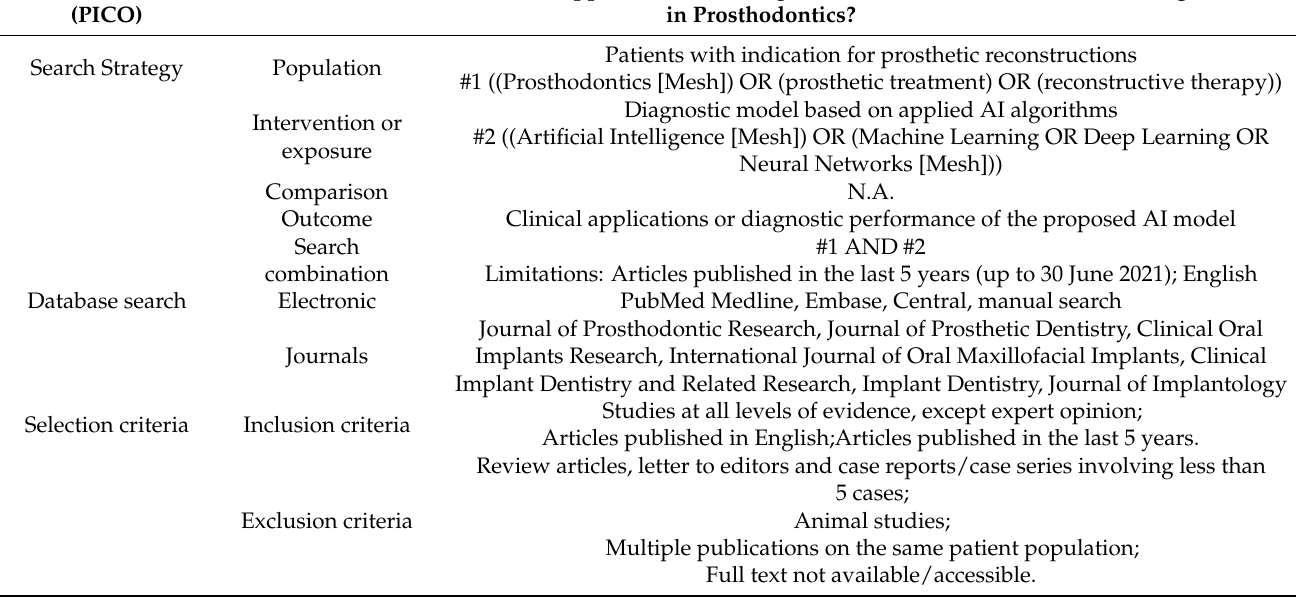
Table 1. Search strategy according to the PICO